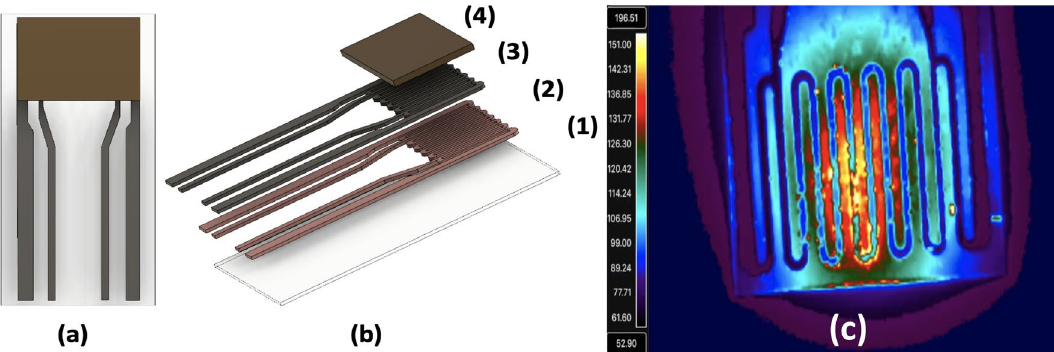
Figure 1. Schematic of a thermodynamic sensor ( a ), ( b ) showing the various layers comprising the sensor: YSZ substrate (1), copper adhesion layer (2), palladium microheater (3), metal oxide catalyst (4) and a high resolution IR image of a thin film microheater fabricated onto a 20 µm thick YSZ substrate responding to an explosive analyte ( c